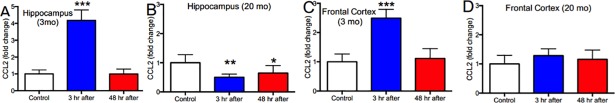
Isoflurane produces age- and region-dependent changes in CCL2 expression.Mice were anesthetized as described and CCL2 measured by RT-PCR. CCL2 was upregulated transiently in both regions in young mice after anesthesia (panels A & C). In old mice, however, isoflurane had no effect in the cortex (D) but persistently decreased CCL2 in the hippocampus (panel B). Data expressed as mean ± SD; N = 5 animals per treatment condition. * p<0.05, ** p<0.01, *** p<0.001 relative to age-matched controls by 1-way ANOVA with Dunnett’s test.